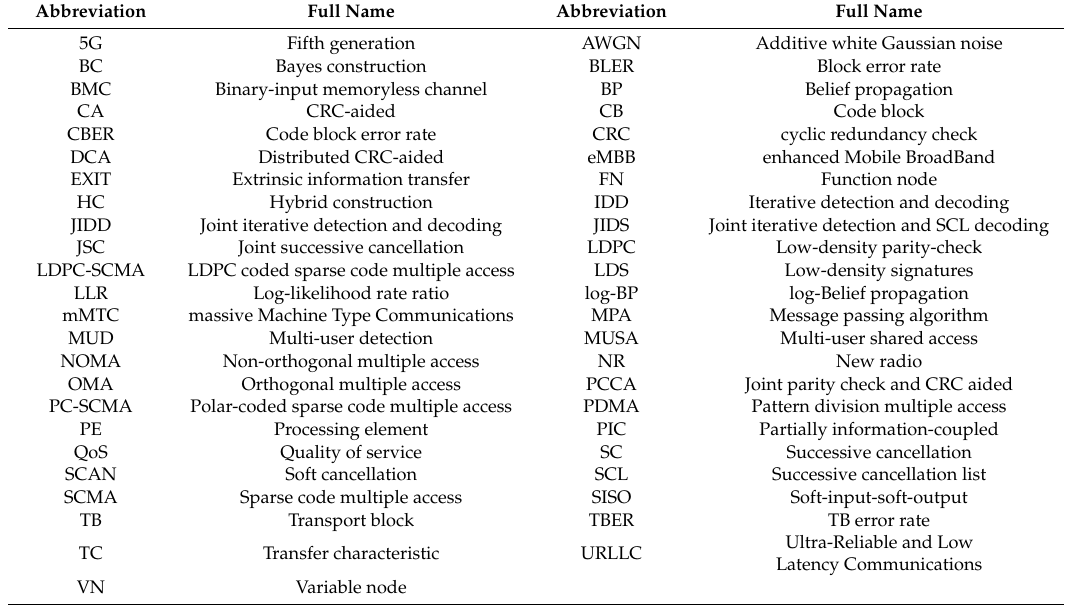
4 of 22 Table 1. Summary of abbreviations. Abbreviation